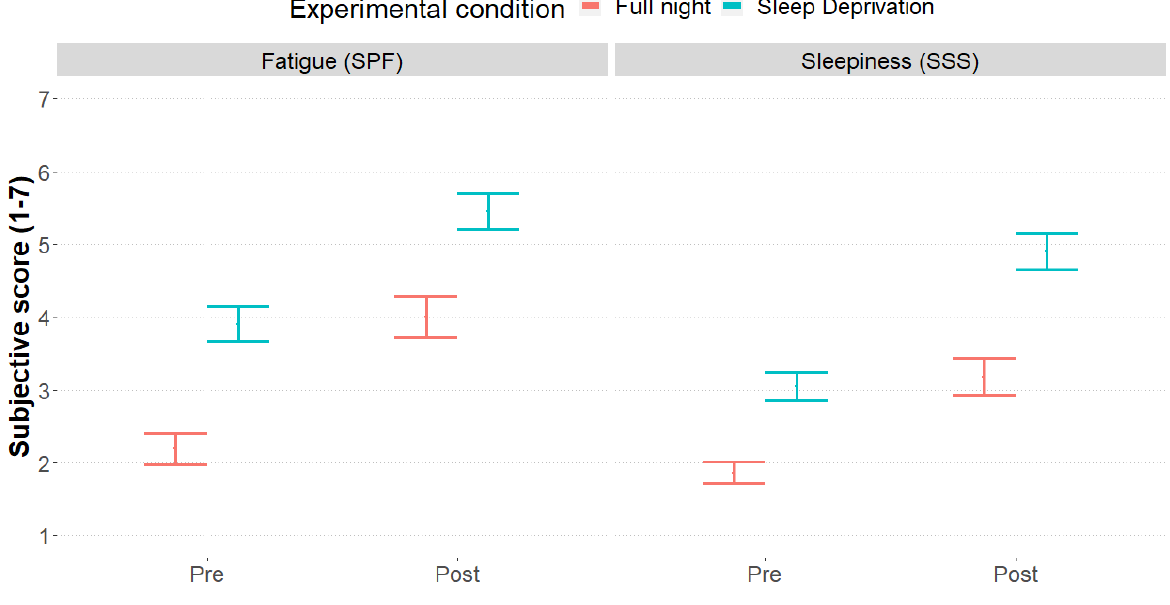
Figure 4. Mean and standard errors of fatigue scores (SPF, left ) subjective sleepiness (SSS, right ) and, divided by experimental phase (Pre, Post) and experimental condition (red: full sleep night with 8 h sleep; blue: sleep deprivation with 5 h sleep). Table 2. Mean and standard deviation (between brackets) of the three subjective measures considered (range from 0 to 10, with 10 = maximum intensity), divided by: experimental condition (full sleep night with 8 h sleep; sleep deprivation with 5 h sleep), experimental time (only sleepiness while driving, five 10 min blocks), experimental phase (SSS and SPF, before and after the driving sessions), and kilometers travelled per year (more or less than 5.000). Sleepiness (While Driving) Sleepiness (SSS, Pre ‐ Post)